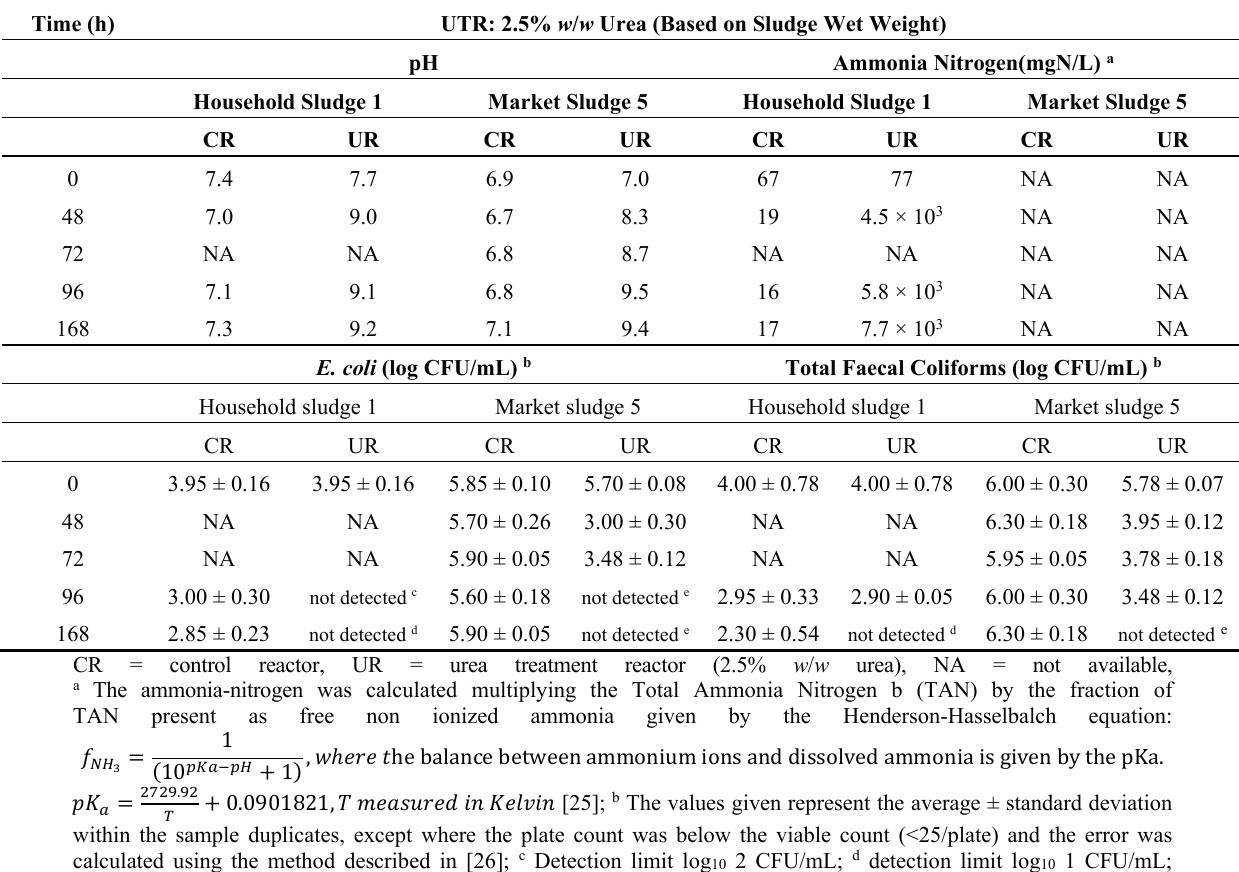
Table 3. Process monitoring of the urea/ammonia treatment process in the field with sludge 1 and sludge 5 (cf. Table